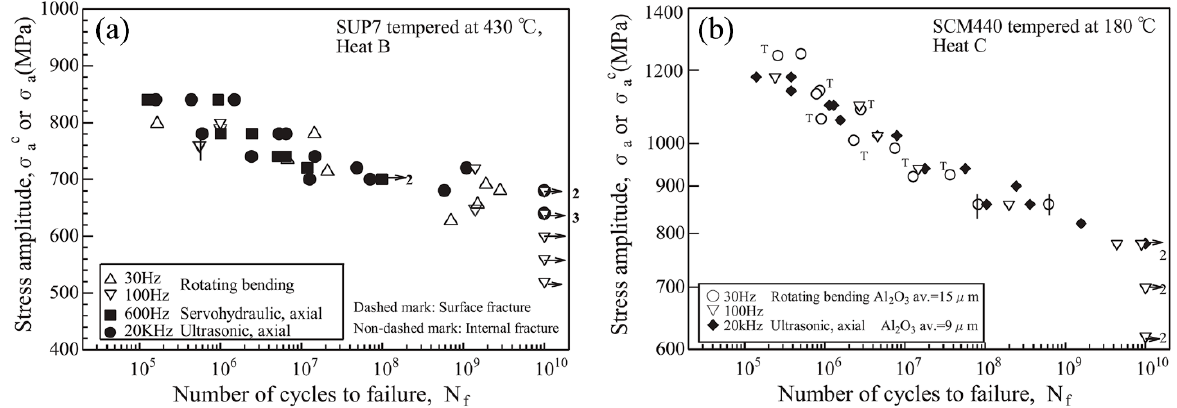
Figure 7. Fatigue data of high-strength spring steel SUP7 ( a ) and low-alloy steel SCM440 ( b ) with rotating-bending equipment (30 Hz and 100 Hz), servo-hydraulic equipment (600 Hz), and ultrasonic equipment at 20 kHz [42].